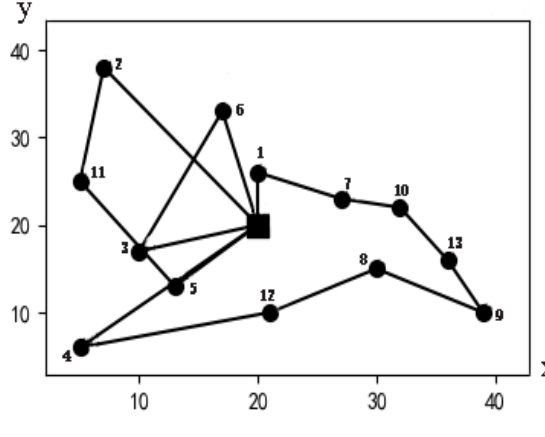
Figure 5. The road map of the initial solution.